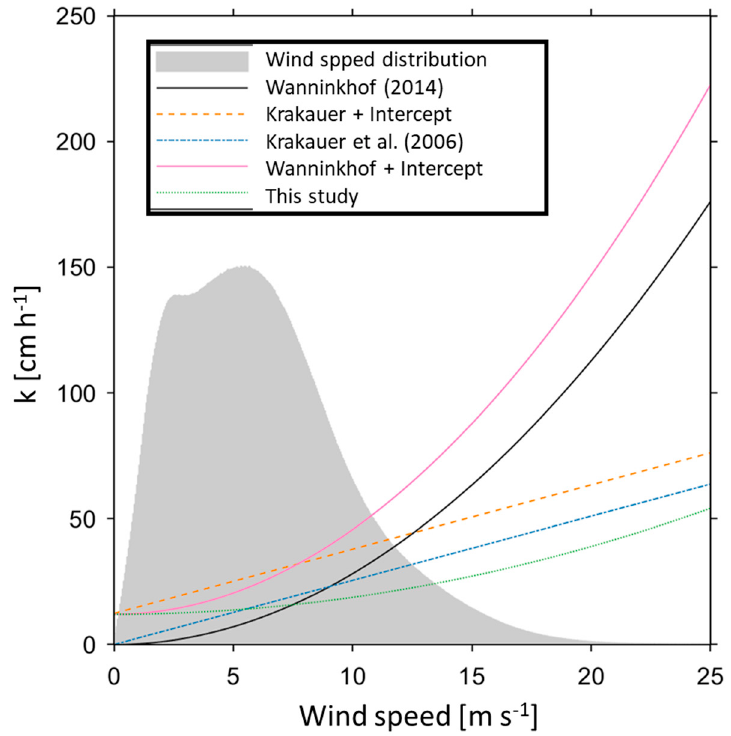
Figure 6. Relationship between gas transfer velocity parameterizations and wind speed and the histogram of global wind distribution for the year 2000 as an example.